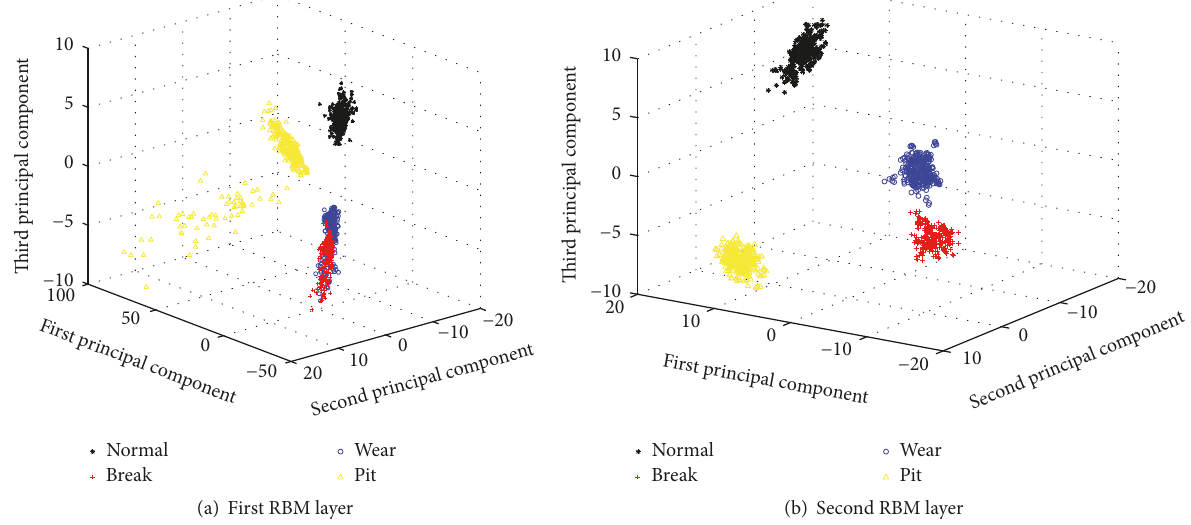
Figure 9: Features distribution of DBN